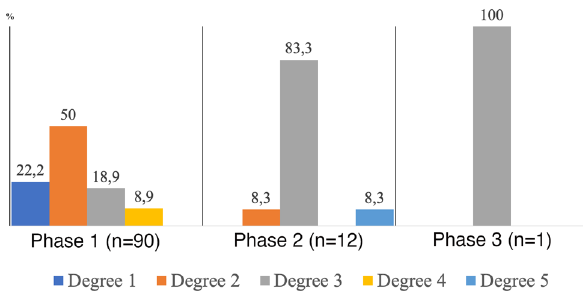
Figure 7: Histogram with the relative abundance ( % ) of burning damage degree according to the in fi lling phases of